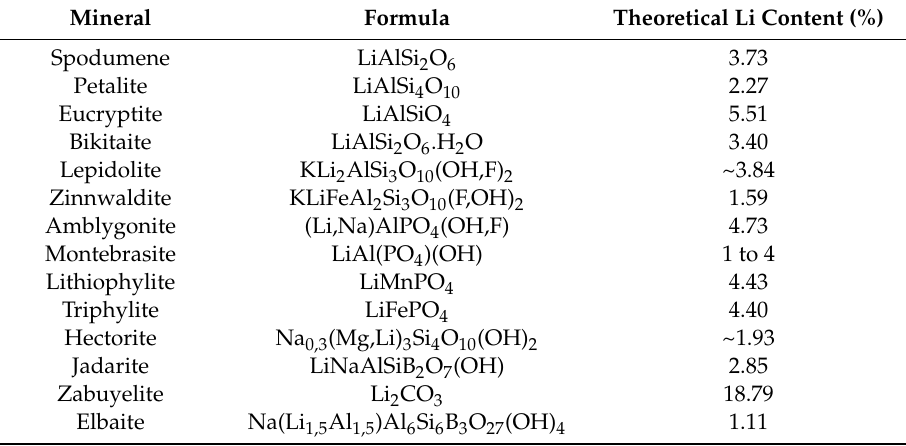
Table 1. Principal lithium-bearing minerals